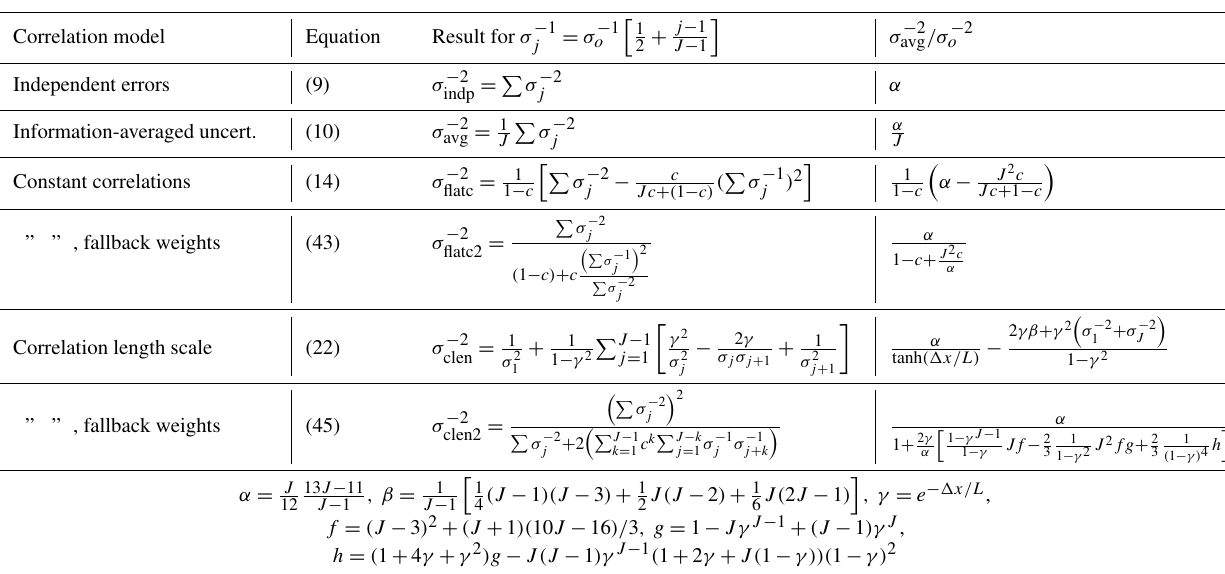
Table 3. The analytical expressions for the uncertainty on the average given by each correlation model for a simple case in which the inverse of the measurement uncertainty varies as σ − 1